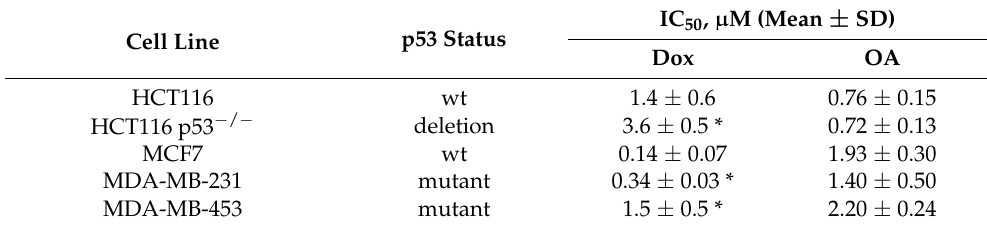
Table 3. OA sensitivity in panel of cancer cell lines with different p53 statuses (MTT test, 72 h). Cell